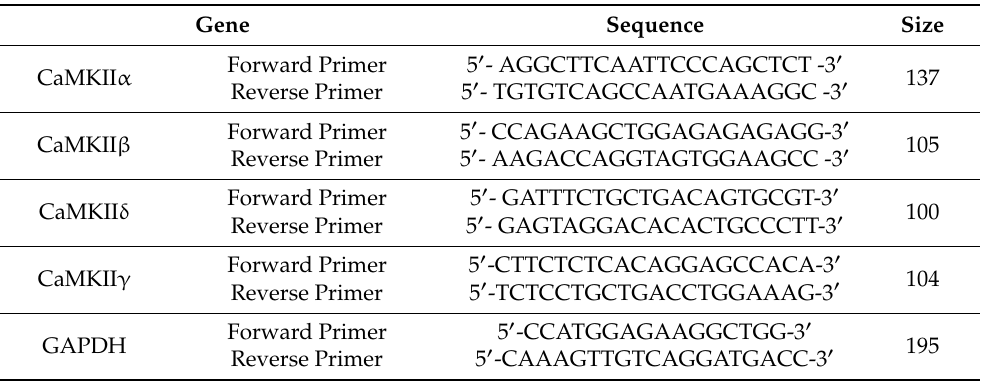
Table 1. Primer sets for PCR and